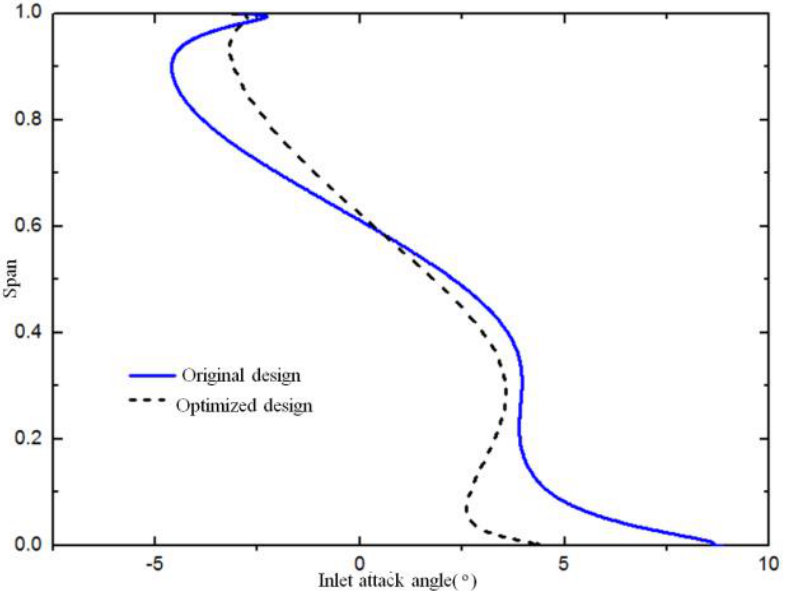
Figure 12. Inlet attack angle distribution of the vaned diffuser.